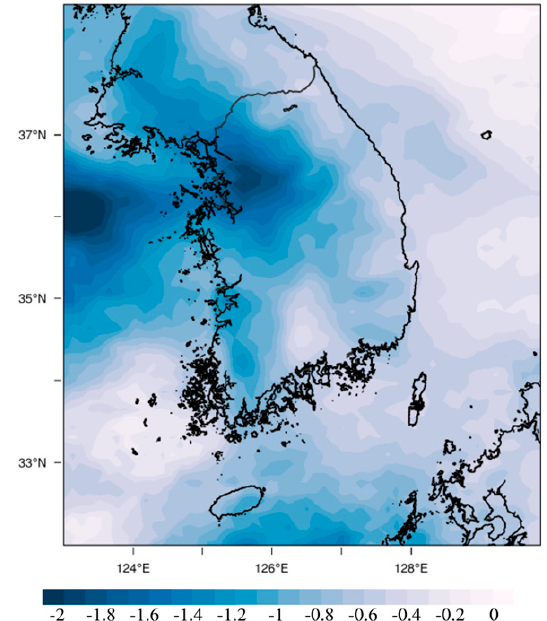
Figure 5. Changes of the sum of SO 42 − , NO 3 − , and NH 4+ concentrations (SO 42 − + NO 3 − + NH 4+ , μ g m − 3 ) in South Korea due to the reduction of SO 2 emissions from foreign sources (R_FSO2–BASE). 3.3. The Difference in Aerosol Direct Radiative Effect in South Korea Due to the Reduced Foreign SO 2